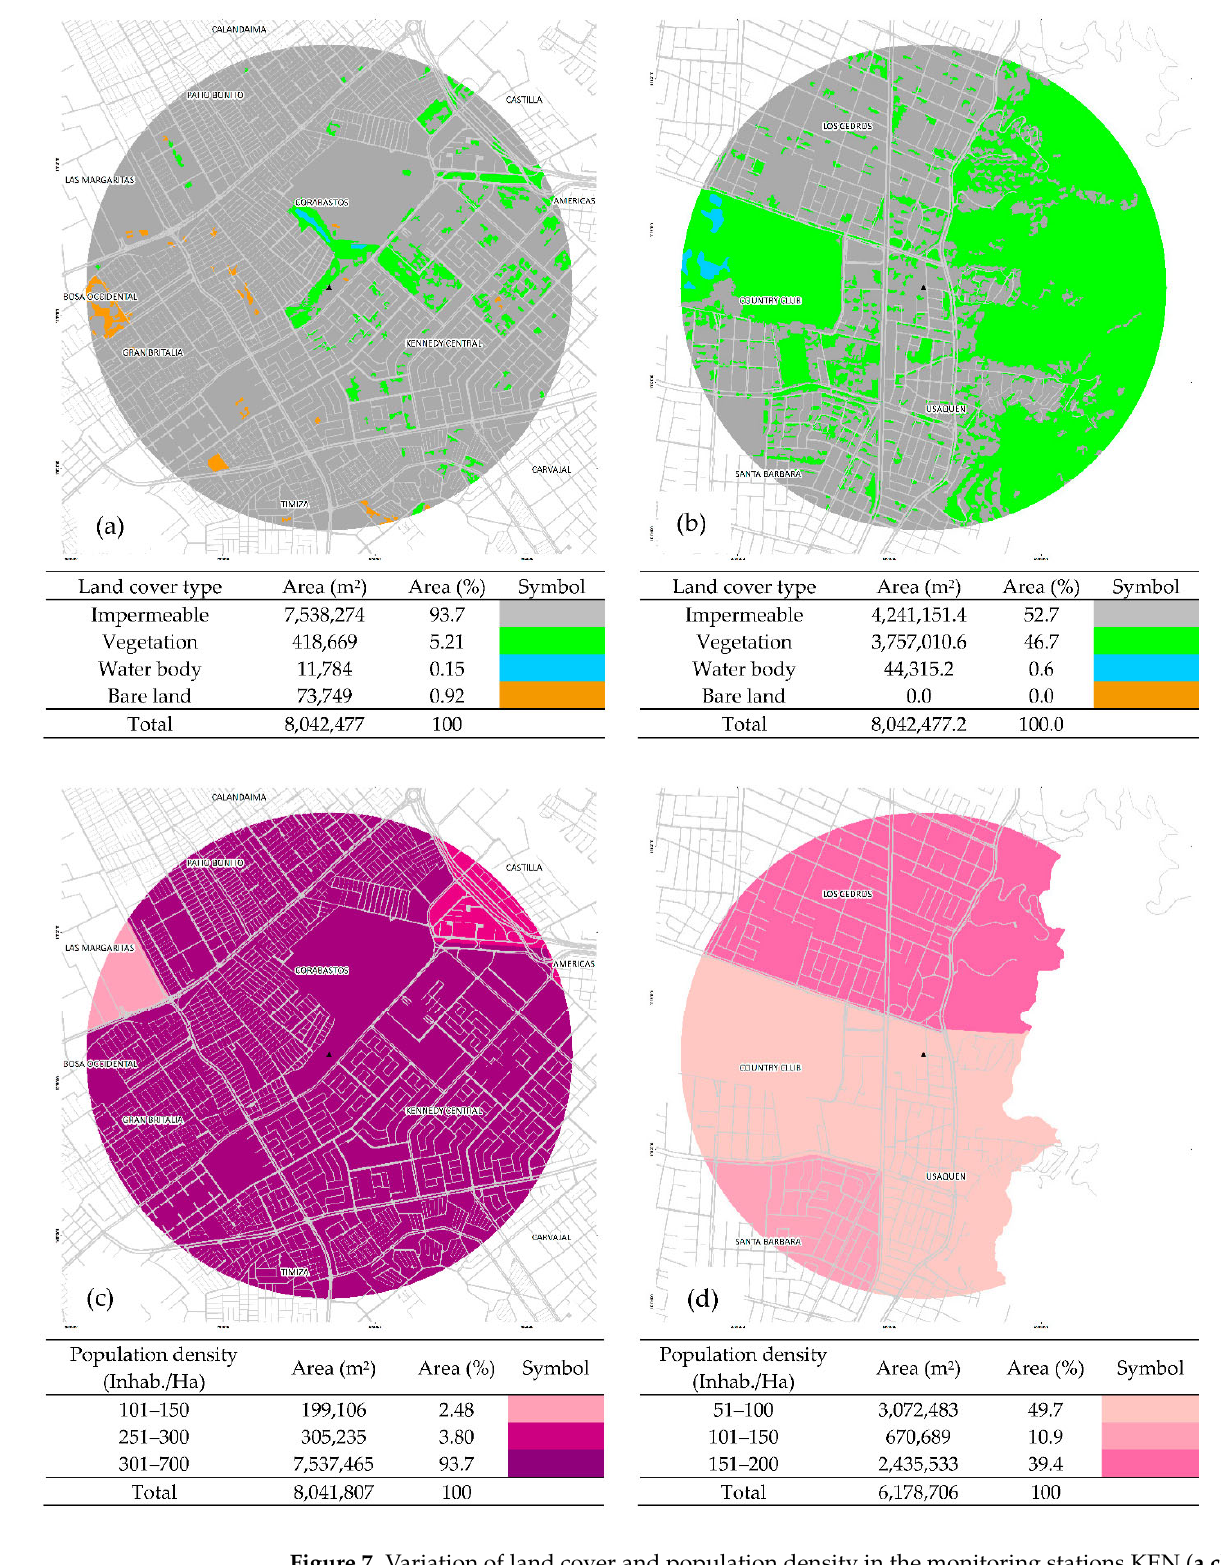
Figure 7. Variation of land cover and population density in the monitoring stations KEN ( a , c ) and USQ ( b , d ).